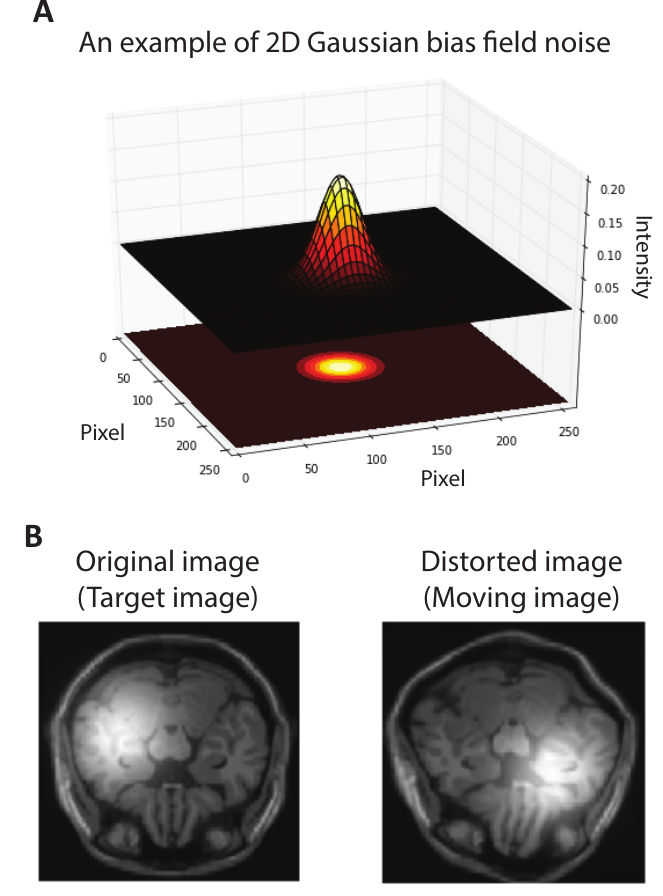
Figure 1. Simulated bias field noise in MR image. ( A ). Sample two-dimensional Gaussian func- tion. ( B ). We manually add A Gaussian function with random mean to both floating and reference MR